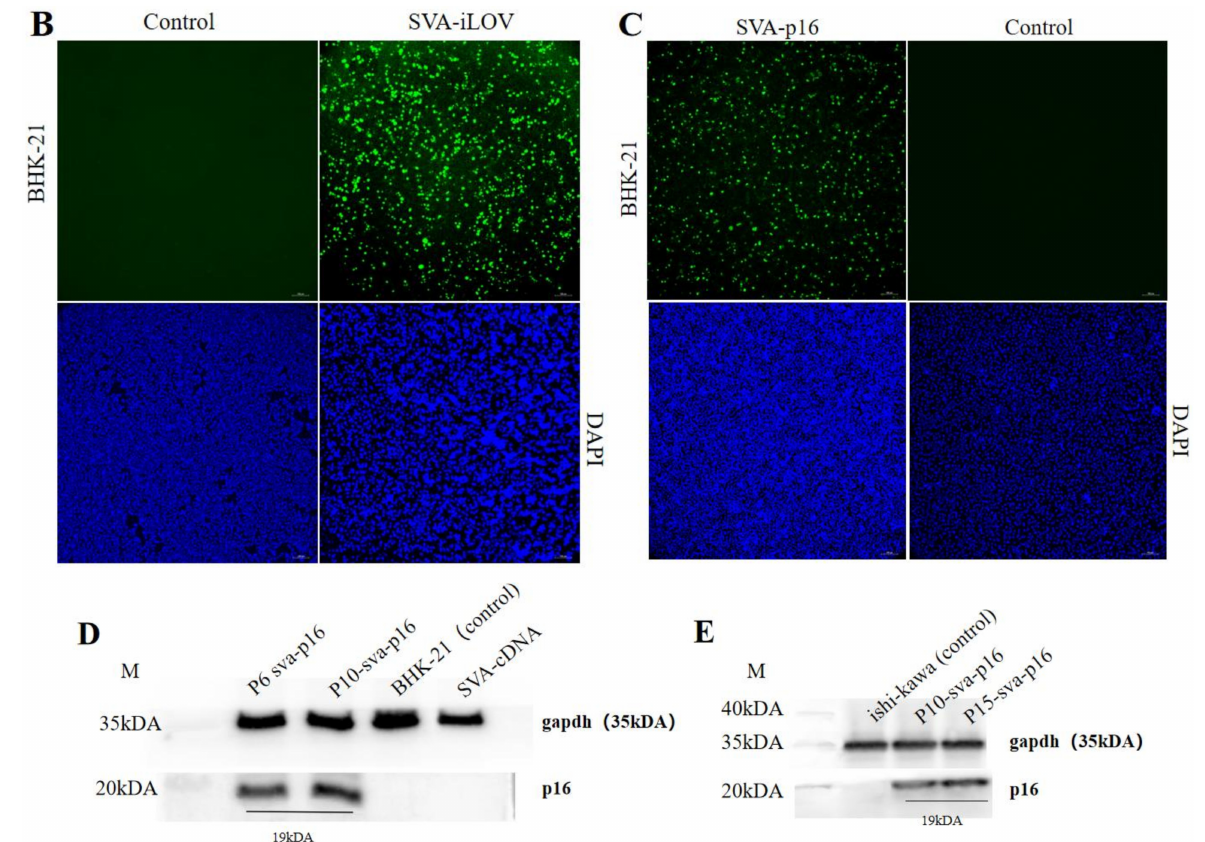
Figure 2. Recovery and characterization of recombinant virus. ( A ) ST-R and BHK-21 cells were infected, respectively, with SVA-clone, SVA-p16, and SVA-iLOV. After 24 h, CPE was observed under microscopy (10 × ). The ruler: 5 µ m. ( B ) The fluorescence was observed in the SVA-iLOV-infected BHK-21 cells at 18 h (10 × ). The ruler: 100 µ m. ( C ) Indirect immunofluorescence assay (IFA) of SVA- p16 and non-infected-BHK-21 cell monolayers (MOI = 1.0) at 18 h using anti-p16 INK4A polyclonal antibody (10 × ). The ruler: 100 µ m. ( D , E ) Cell lysates from the recombinant viruses infected BHK-21 and Ishikawa cells, respectively, with PN-SVA-p16, and non-infected cells were harvested at 36 h. The expression of recombinant proteins was analyzed by Western blot using p16 polyclonal